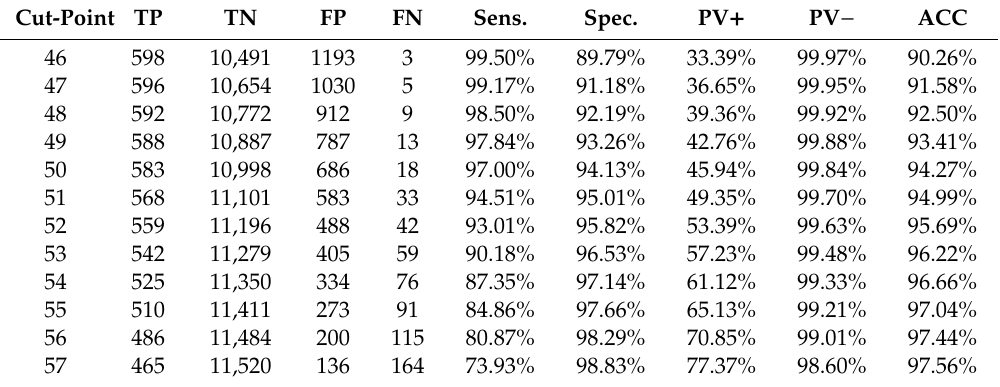
Table7. Cut-o ff